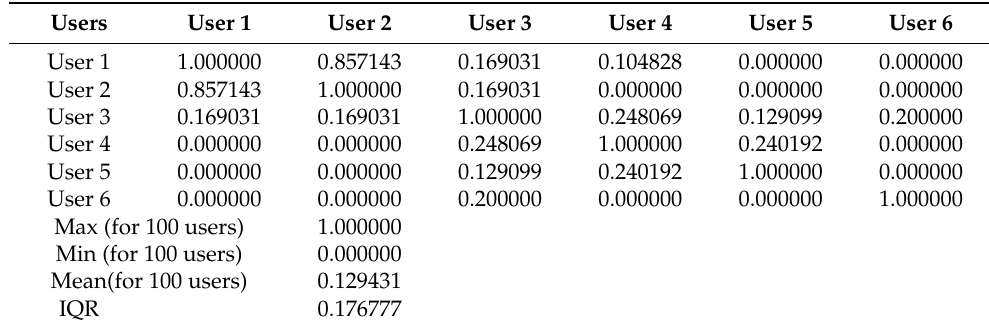
Table 8. Similarity Matrix based on Topics.